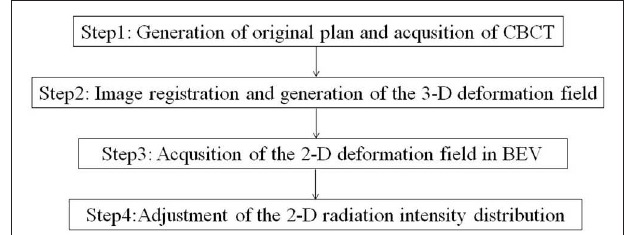
FIGURE 1 | Flowchart of the IFP